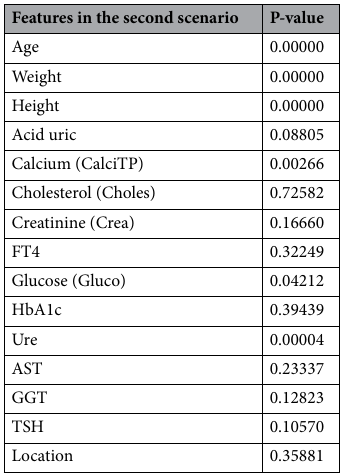
Table 8. The relationship among various features in the second